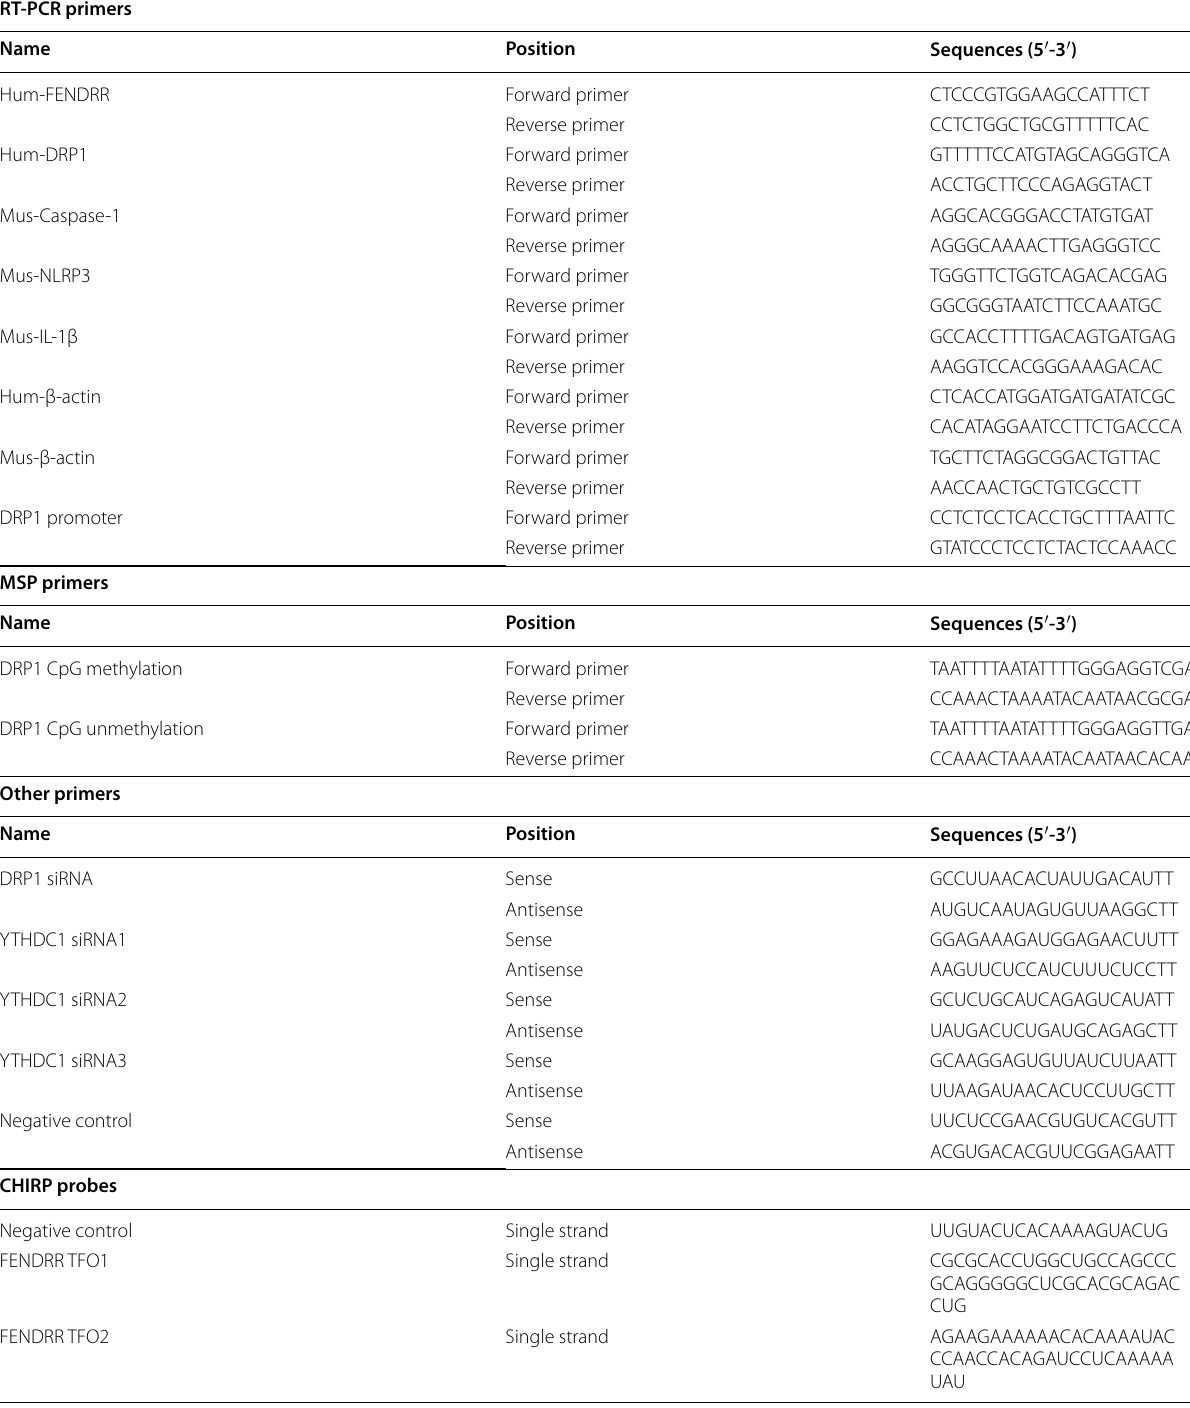
Table 1 All primers and probes sequences RT-PCR